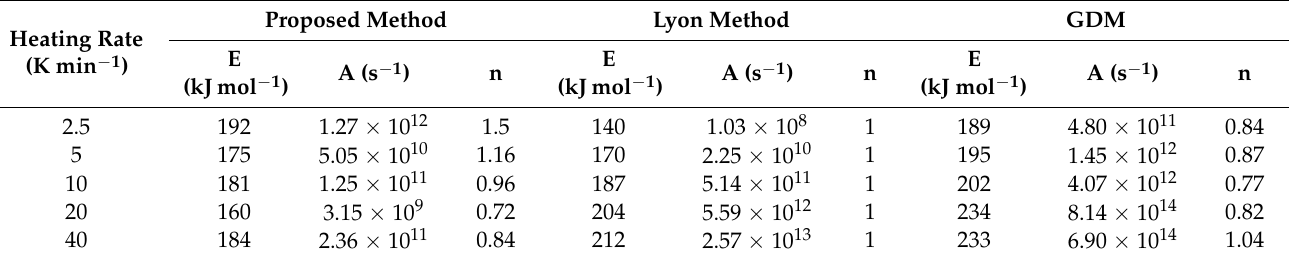
Table 2. Comparison of kinetic parameters for the decomposition reaction of PA6.6.